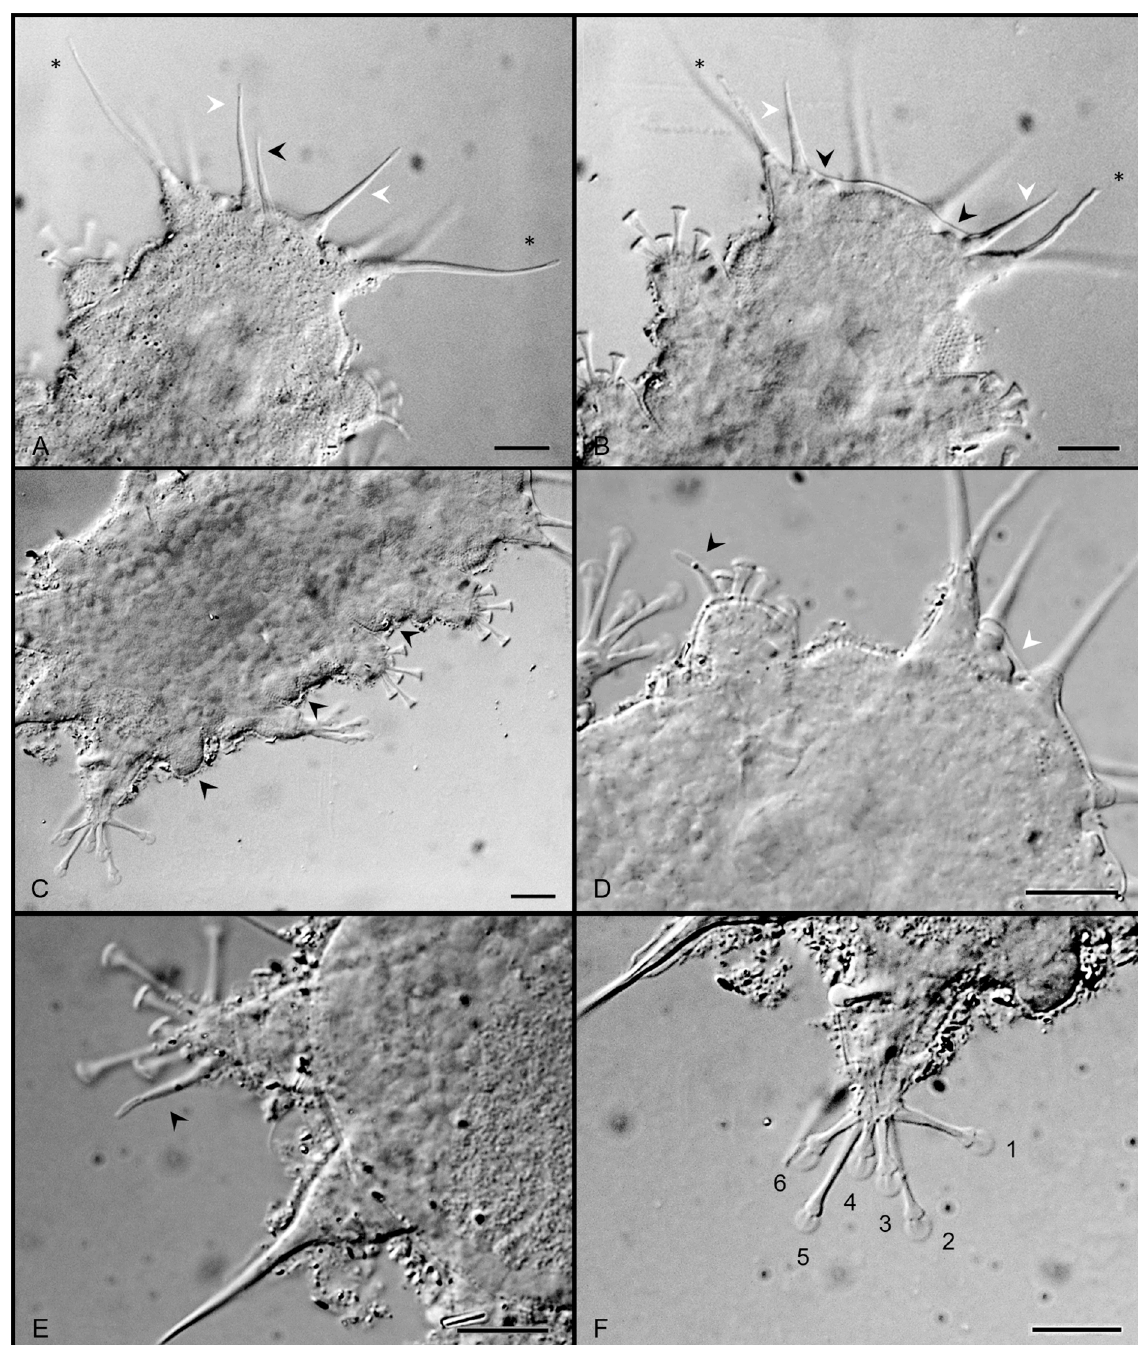
Fig. 3. Batillipes algharbensis sp. nov., holotype, ♀. A–B . Detail of the head. A . Dorsal view, showing median cirrus (black arrowhead), internal cirri (white arrowheads), lateral cirri (asterisks). B . Ventral view, showing primary clavae (asterisks), secondary clavae (black arrowheads), external cirri (white arrowheads). C–E . Body. C . Ventral view, showing ventro-lateral projections (black arrowheads). D . Anterior portion with details of leg spine I (black arrowhead), note the secondary clavae (white arrowhead). E . Posterior portion with details of leg sensory organ on leg IV (black arrowhead). F . Fourth leg with details of toes (1–6). Scale bars = 10